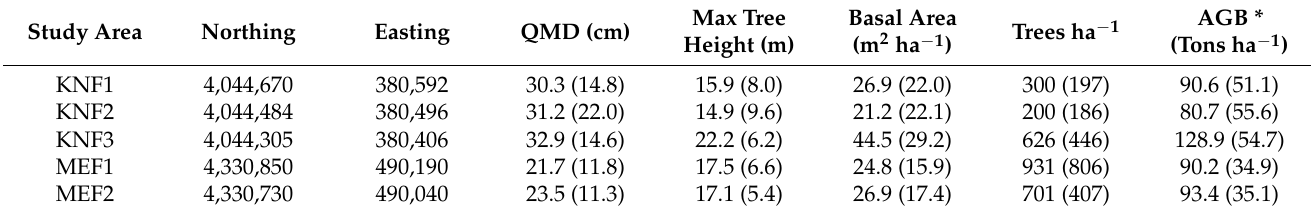
Table 1. Location and forest stand structure at the Kaibab National Forest (KNF) and Manitou Experimental Forest (MEF) study units, reported as a mean (standard deviation) of 0.01 ha sampling unit. The locations are reported as site centroids using North American Datum 1983 Universal Transverse Mercator in Zone 12 North for KNF and Zone 13 North for